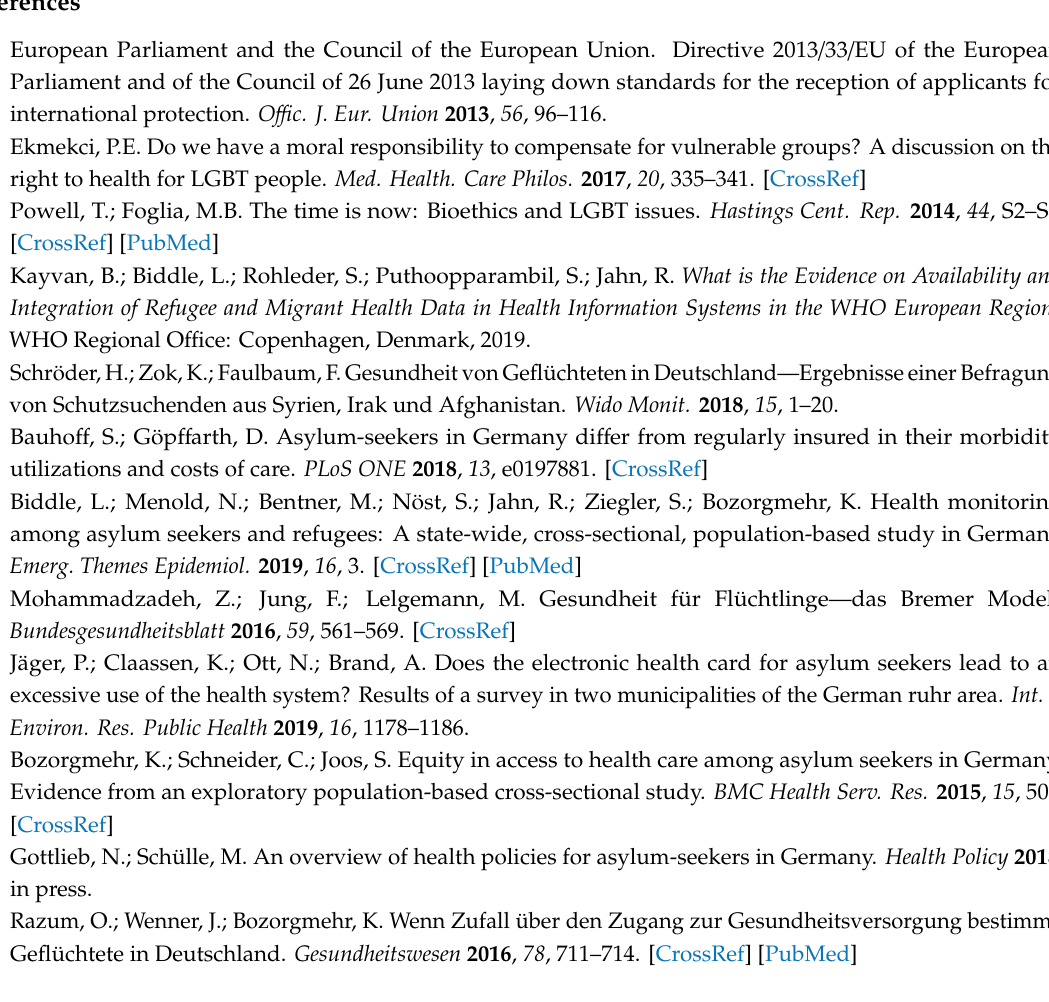
Table S1: Generalized Linear Mixed Model examining the association between living in the LGBTIQ shelter and the probability of ambulatory healthcare utilization, with chronic disease as fixed e ff ect and subjective health status as random e ff ect (n = 236), Table S2: Generalized Linear Mixed Model examining the association between residence in the LGBTIQ shelter and the probability of mental healthcare utilization, with mental health need as fixed e ff ect and length of stay in Germany as random e ff ect (n =